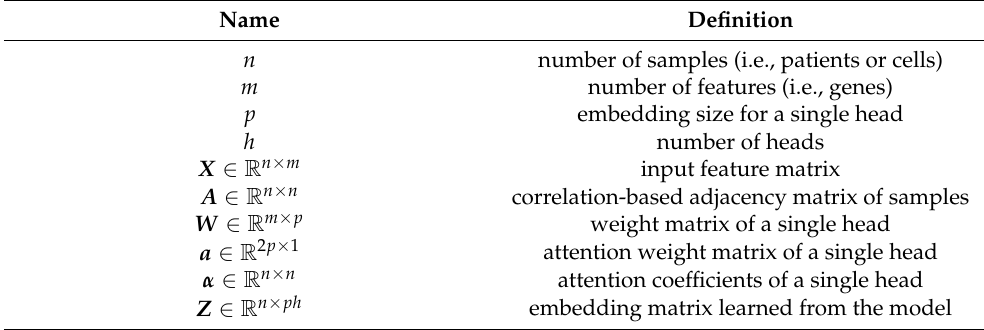
Table 6. Mathematical notations for